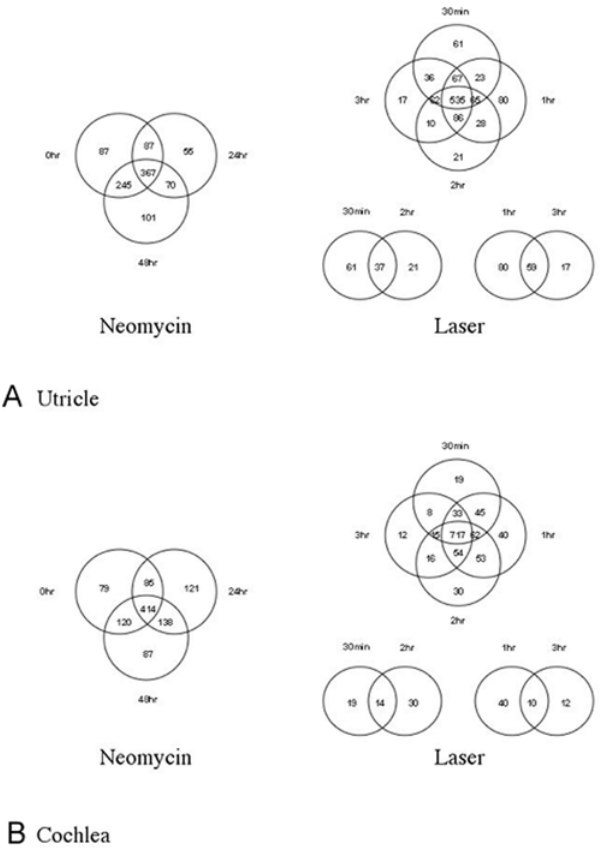
Figure 4. Detectably expressed TFs in the four treatment/time course combinations. All TFs that were present (as judged by